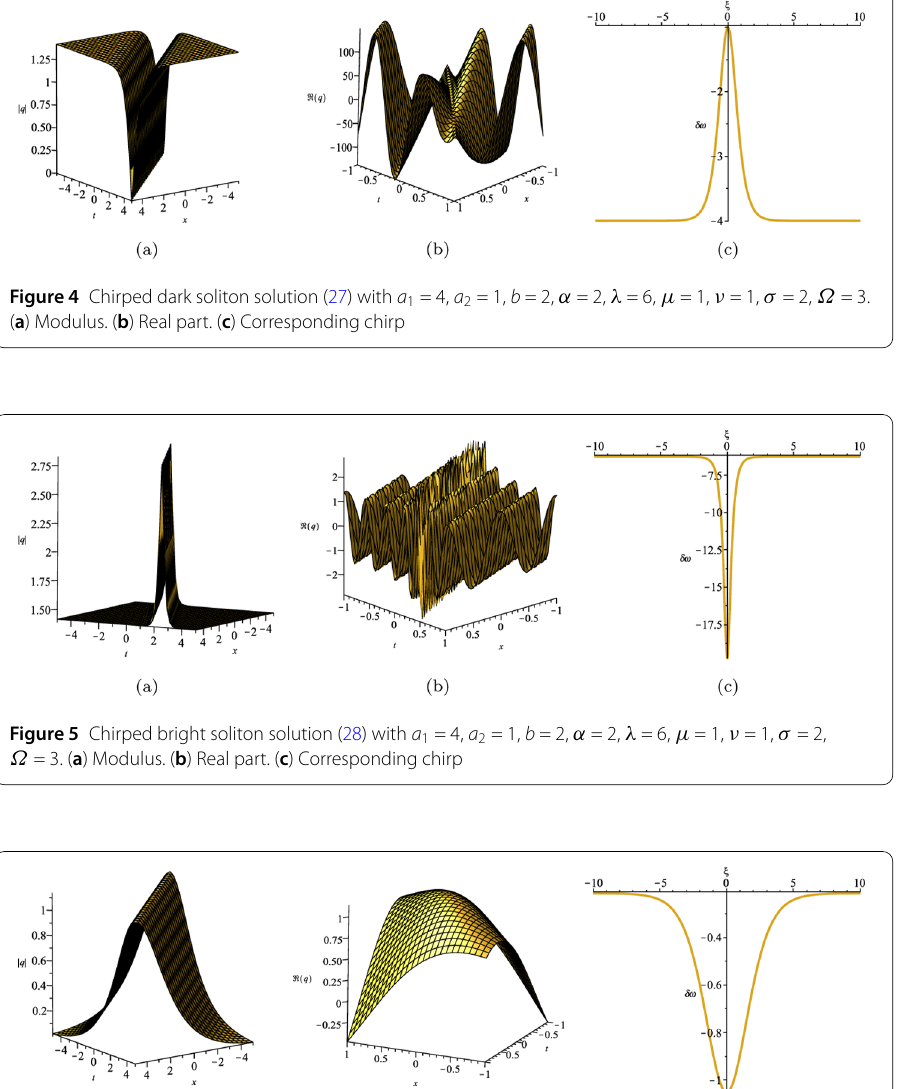
are shown in Fig. 3(b)–(c). We describe the modulus of chirped dark soliton solution (27) in Fig. 4(a). Its real part and corresponding chirping are presented in Fig. 4(b)–(c). The modulus of chirped bright soliton solution (28) is depicted in Fig. 5(a) while the real part and associated chirp of solution (28) are plotted in Fig. 5(b)–(c). Using different values of parameters, the modulus of chirped bright soliton solution (41) is shown in Fig. 6(a) and, its real part and corresponding chirping are presented in Fig. 6(b)–(c), where a 1 = 3, a 2 = –4, b = 2, α = –6, λ = 6, μ = 1, ν = 1, σ = 2, Ω = –2. Figure 7(a) displays the modulus of another type of chirped singular soliton given by (42). The real part and associated chirp of solution (42) are illustrated in Fig.